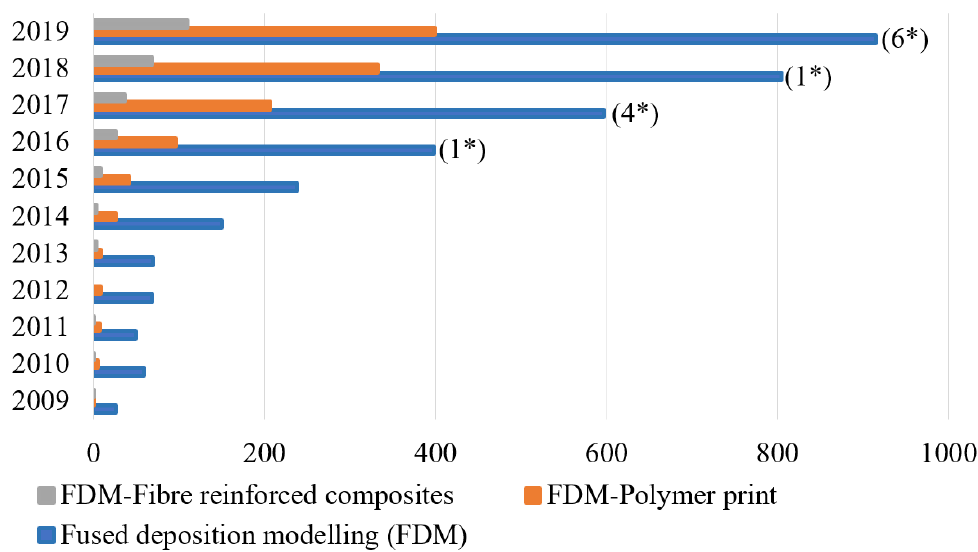
Figure 3. Number of publications on: FDM, FDM ‐ polymer prints and FDM ‐ fibre ‐ reinforced composites from 2009 to 2019. The number within the brackets indicate the number of review papers on FDM ‐ fibre ‐ reinforced composites. Data obtained from the Web of Science.